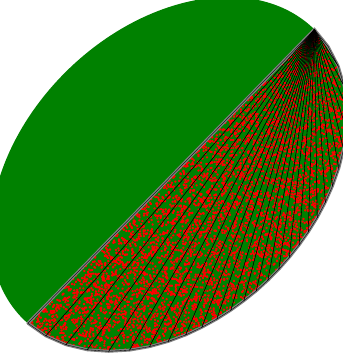
Target ship Figure 7. Ship collision avoidance direction in each situation. (a) Head-on. (b) Overtaking. (c) Crossing.